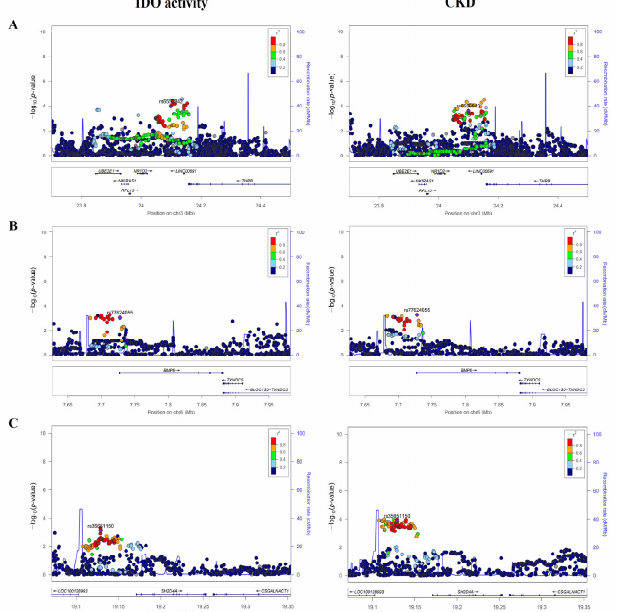
Figure 1. Regional association plots of IDO activity and CKD at 3p24.2 ( A ), 6p24.3 ( B ) and 8p21.3 ( C ) loci. Statistical significances of SNPs near NKIRAS1 , BMP6 , and SH2D4A for IDO activity and CKD are plotted as − log 10 p -values. The purple diamond ( (cid:7) ) represents the SNP strongly involved in both CKD and IDO activity. Levels of linkage disequilibrium ( r 2 ) of top SNPs and surrounding SNPs are shown in different colors. These regional plots for SNPs were generated via LocusZoom(http://locuszoom.org/ (accessed on 10 March 2023)). IDO, indoleamine 2,3-dioxygenase; CKD, chronic kidney